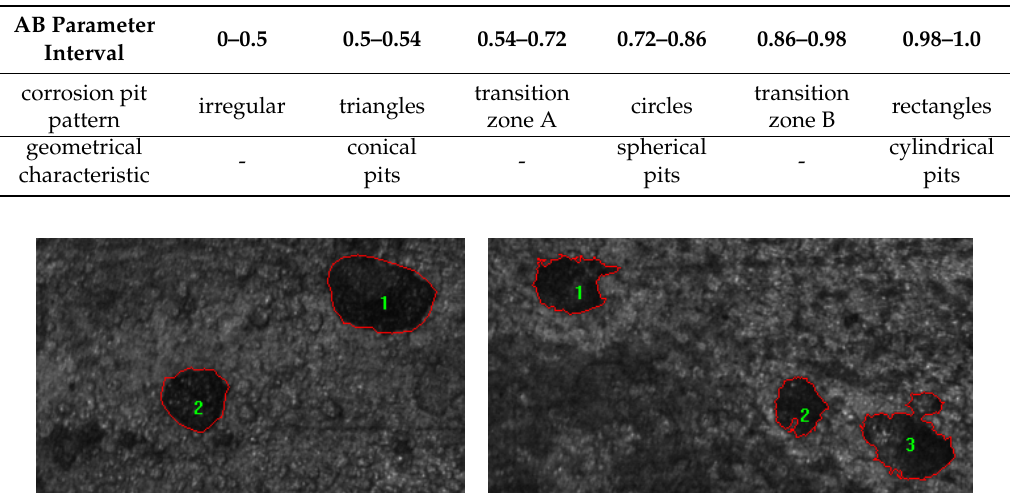
Table 2. Corrosion mass loss ratio ( S ) of corroded reinforcement.